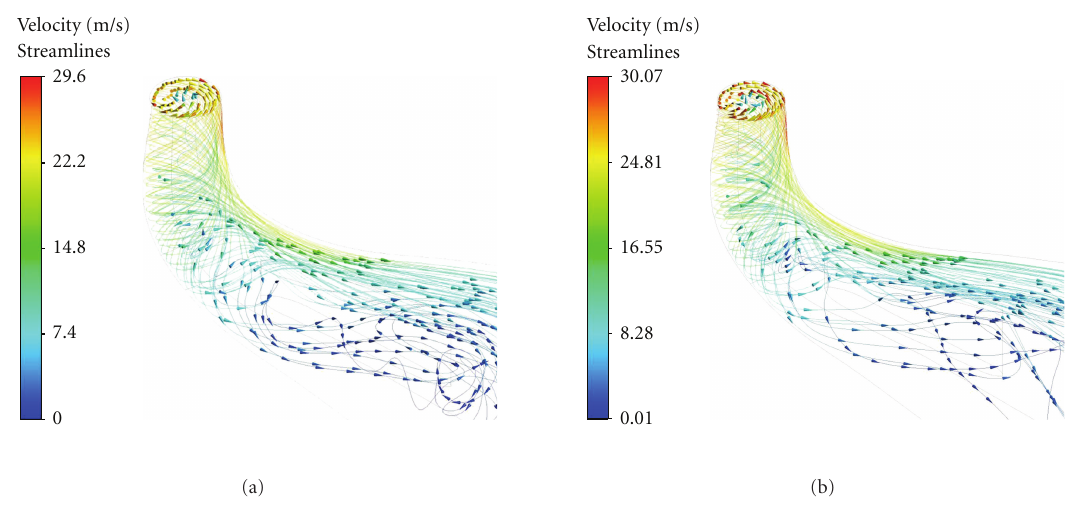
Figure 9: Streamlines at di ff erent flow rates (a) 76.14 m 3 /s and (b) 89m 3 /s.